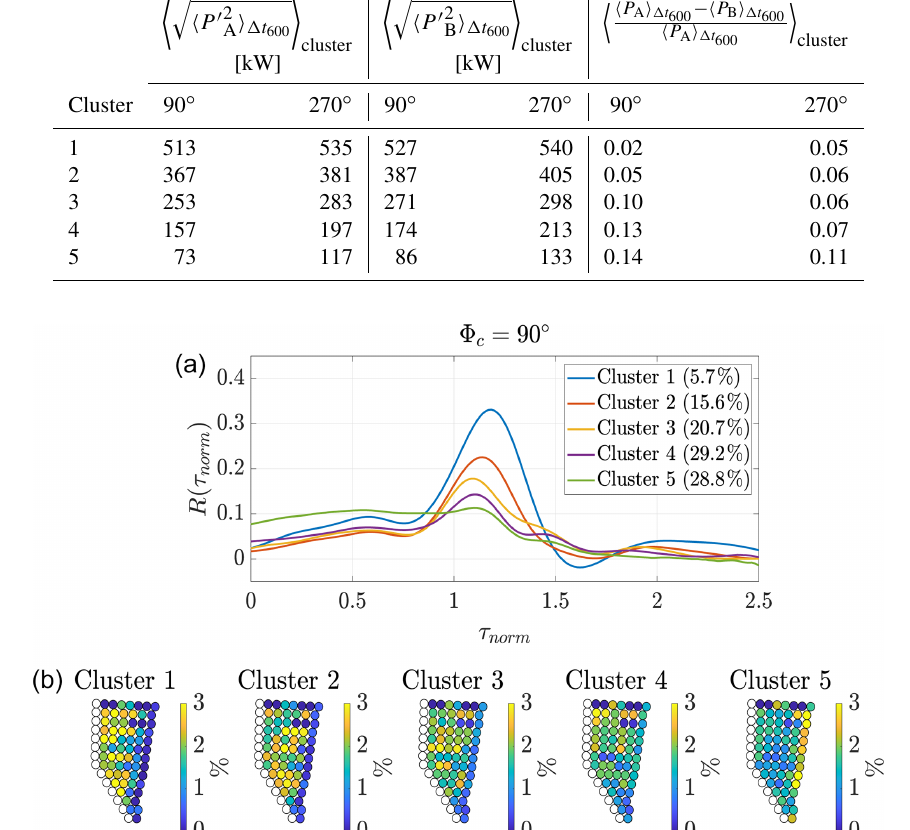
Figure 7. Clustering for wind direction interval around 90 ◦ with randomly sorted 600s time intervals. (cid:56) c depicts the centre of the wind direction interval. Panel (a) plot shows the average power output fluctuation correlation curve per cluster. The legend lists the share of data. Panel (b) shows the percentage frequency of each wind turbine pair within the respective cluster given as colour. As the wind turbines are analysed in pairs of two, the last row of wind turbines is unlabelled, as these wind turbines do not have a downstream